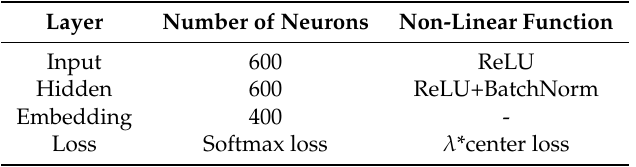
Table 1. The network structure of the deep discriminant